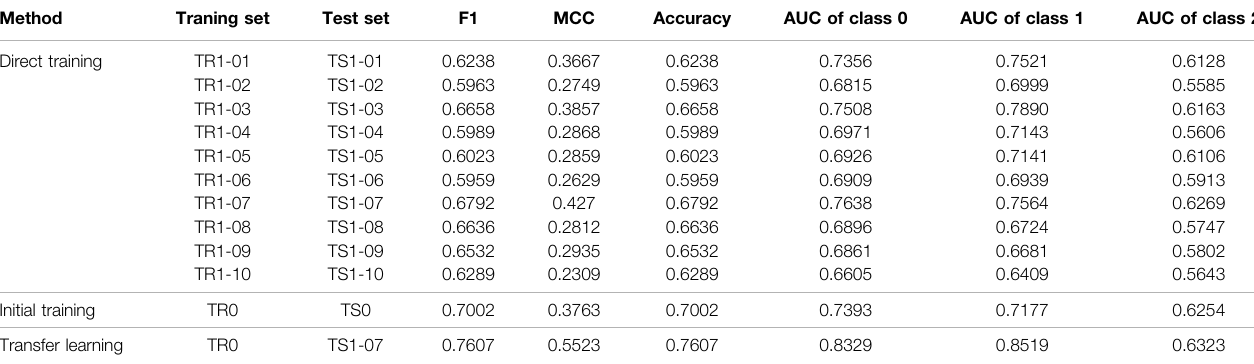
TABLE 1 | Performance of SeqNetQuake on the test set after direct training, initial training, and transfer learning. Data from DEMETER were divided into a training set (TR0) and test set (TS0), and data from CSES were divided into TR1 (training set) and TS1 (test set). Method Traning set Test